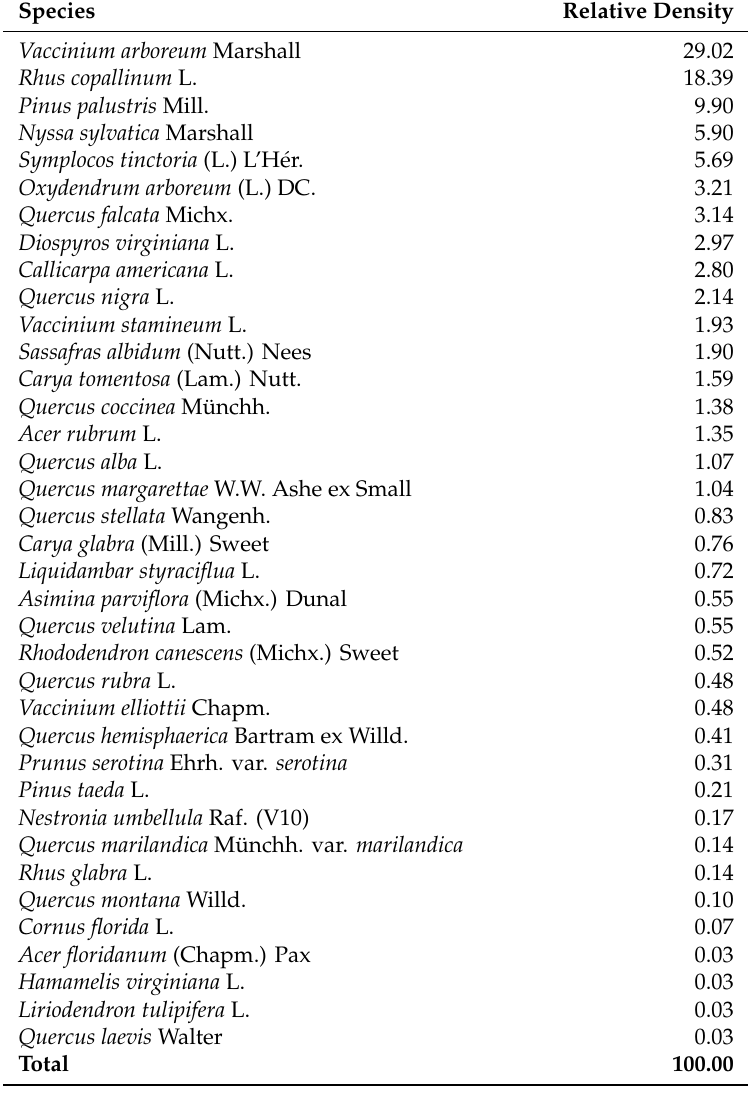
Table 1. Relative density of seedlings (live woody stems < 1 m height) in a Pinus palustris woodland following catastrophic wind disturbance, ordered by relative